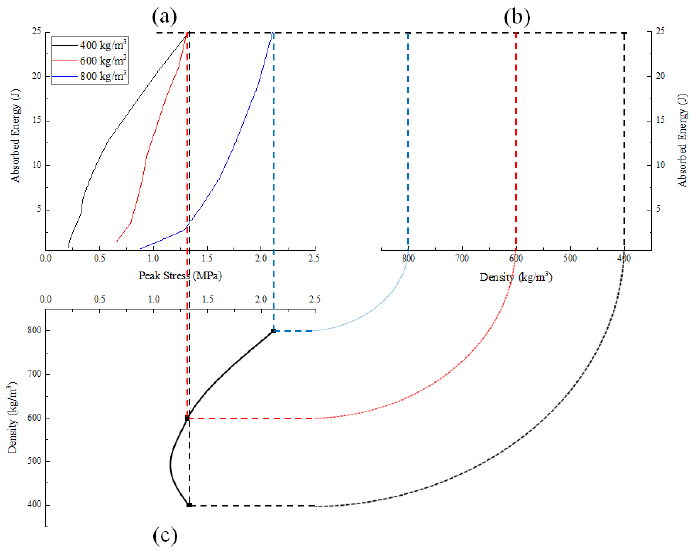
Figure 13. Energy absorption diagrams resulting from dynamic compression tests: ( a ) absorbed en- ergy–peak stress curve; ( b ) absorbed energy–density curve; ( c ) density–peak stress curve.